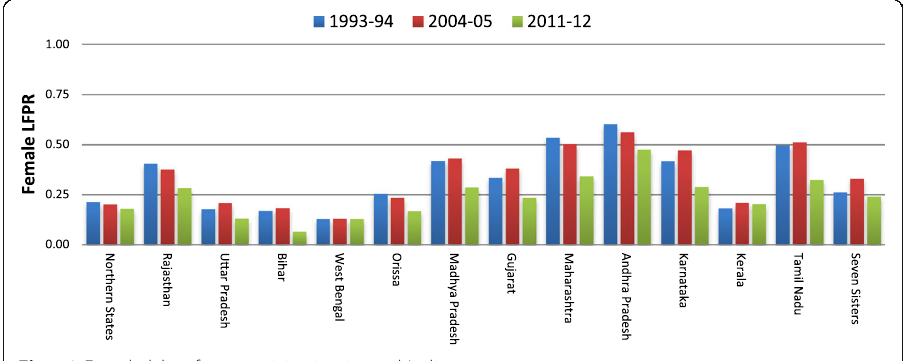
Fig. 12 Female labor force participation in rural